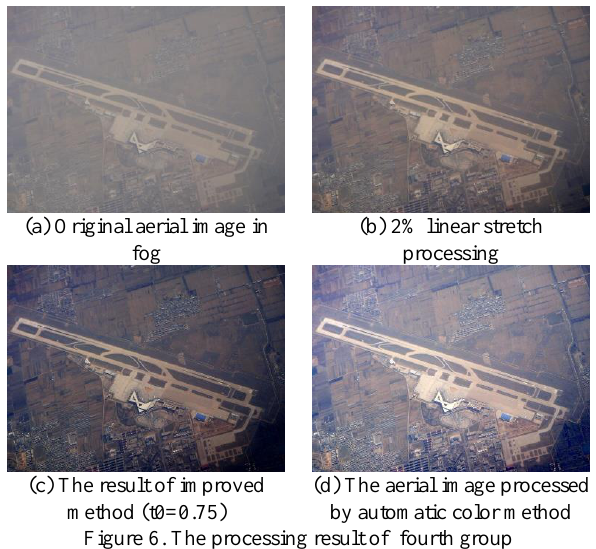
Figure 6. The processing result of fourth